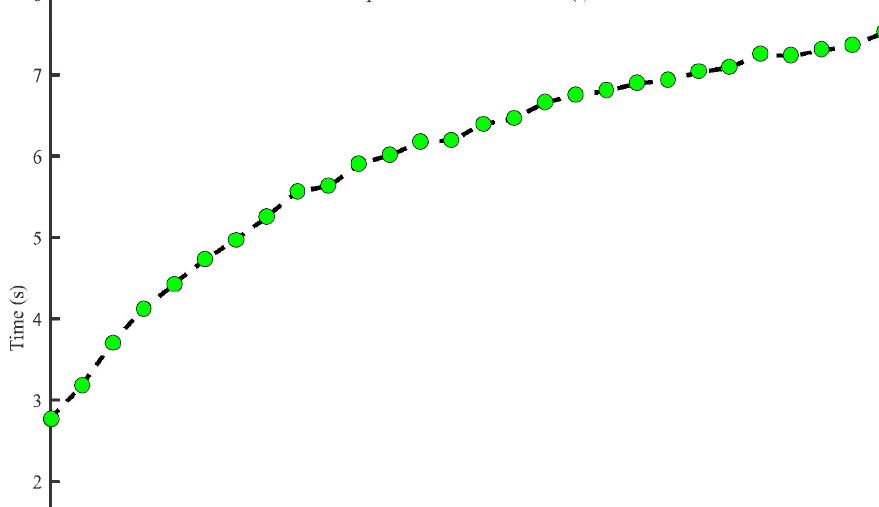
FIG. 12. IMPACT OF RANDOM SEED